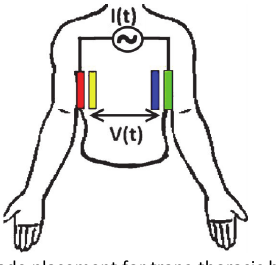
Figure 4. Electrode placement for trans-thoracic bioimpedance measurements: two electrodes (red and green) are used for the application of an excitation current (I(t)), and two electrodes for the measurement of the voltage drop